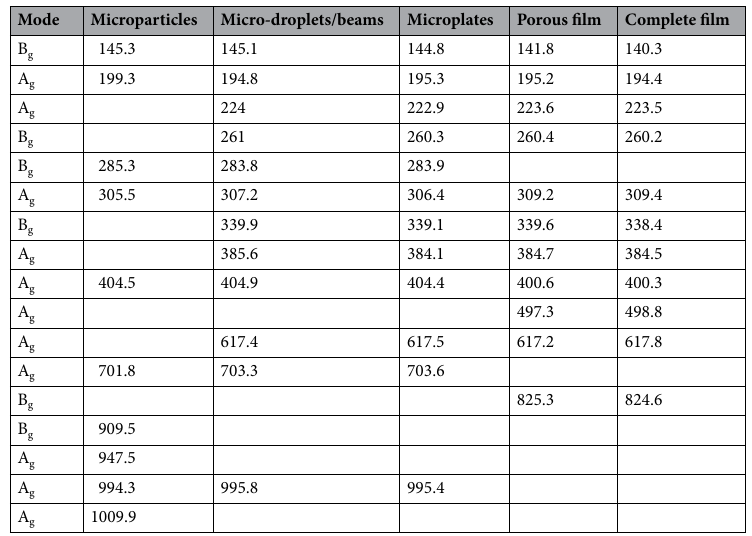
Table 1. Summary of the experimentally observed positions of the Raman ‐ active modes of the growth products at different growth stages.